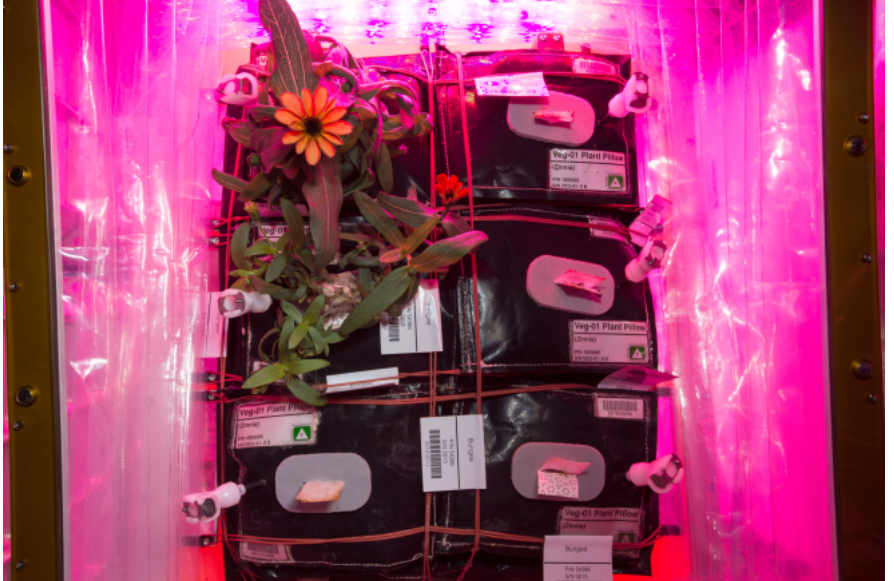
Figure 3. Zinnia plants in flower in the Veggie plant growth system onboard the International Space Station on January 16, 2016. Plants were grown from November 16, 2016 to the date of the photograph by astronauts Kjell Lindgren and Scott Kelly. Growing zinnias on the ISS provided an opportunity for the astronauts to practice gardening in space. The first flowers grown from seed in space occurred previ- ously on Mir, on Salyut-6 in 1982. Russian and American scientists have been conducting plant research in space since the late 1970’s. Image catalogued by Johnson Space Center of the United States National Aeronautics and Space Administration (NASA) Photo ID: ISS046- E-009029. Image credit: NASA https://upload.wikimedia.org/wikipedia/commons/f/fd/ISS-46_Zinnia_flowers_in_the_Veggie_faci-